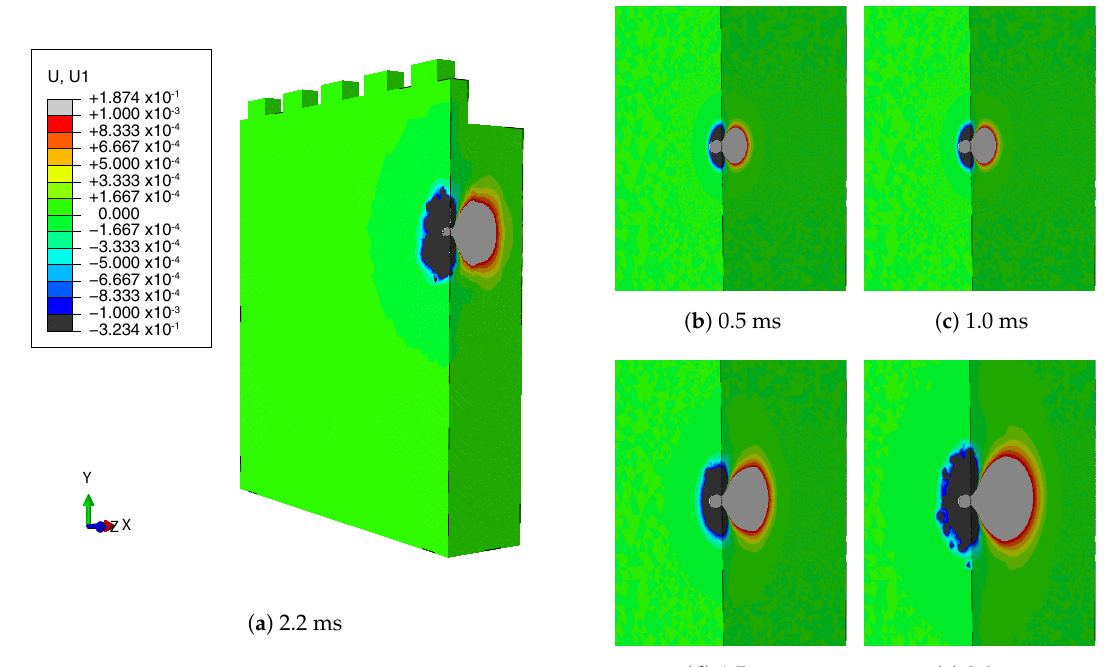
Figure 7. Maps of the displacements in the direction of motion of the ball and zoom on the impact point at different instants of